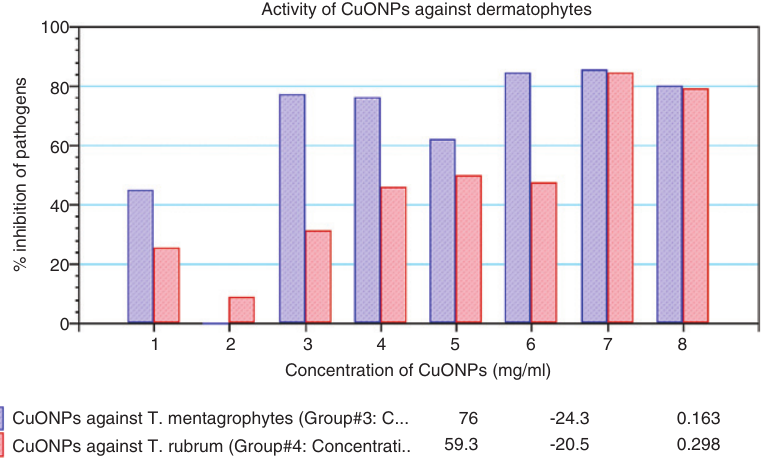
Figure 5: Graphical representation of antifungal susceptibility of dermatophytes against CuO nanoparticles (NPs).